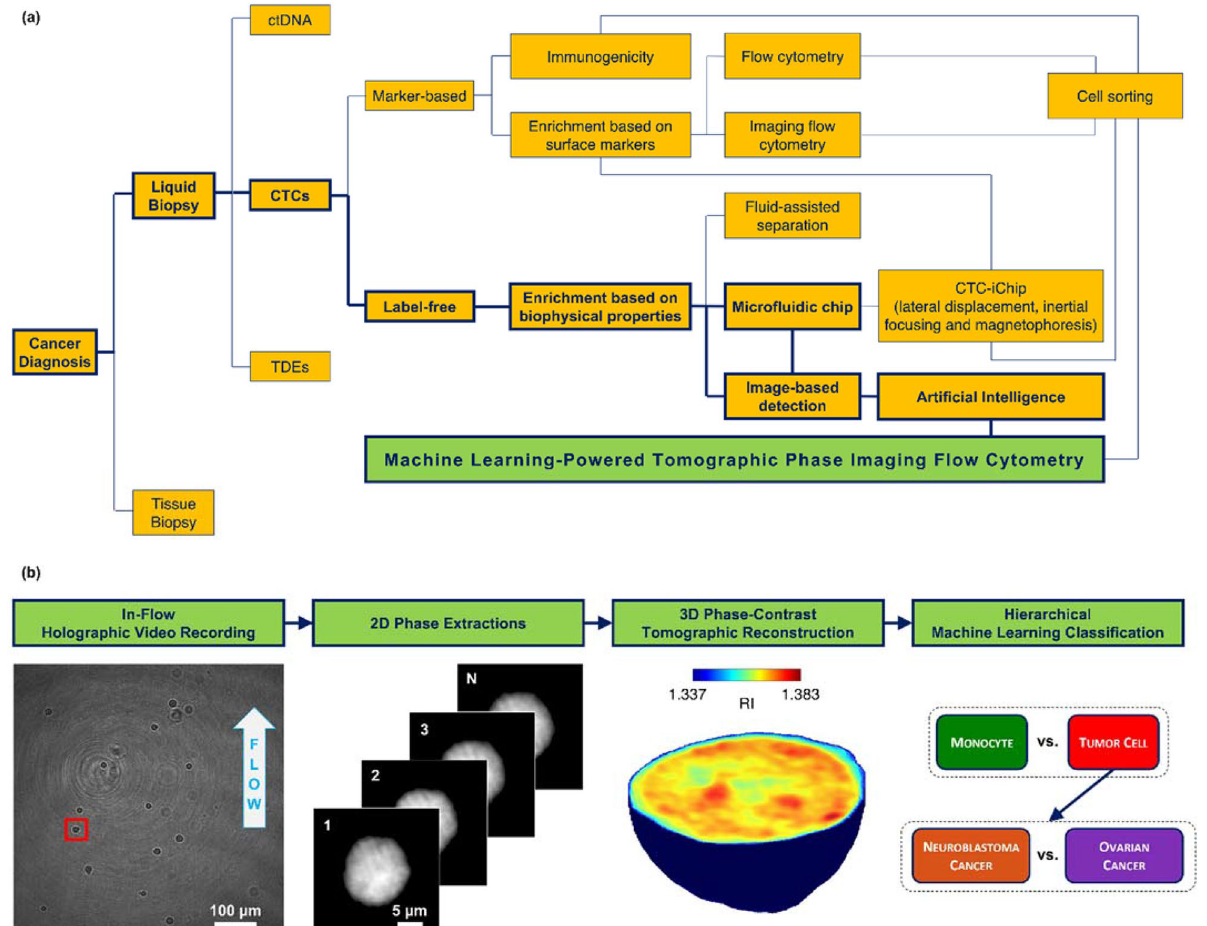
Figure 1. Strategies for implementing liquid biopsy (LB). ( a ) Scheme of the main methods developed for the diagnosis of cancer through LB. The marked pathway leads to the technology presented here for LB applications (green box). ctDNA, circulating tumor DNA; TDEs, tumor-derived exosomes; CTCs, circulating tumor cells. ( b ) Steps of the machine learning-powered tomographic phase imaging flow cytometry. (i) A holographic video sequence containing cells while flowing and rotating along a microfluidic channel is recorded; (ii) for each cell, hundreds of QPMs are numerically computed from the recorded digital holograms; (iii) for each cell, the several QPMs are used to reconstruct its 3D RI tomogram; (iv) the 3D RI tomogram is given in input to a hierarchical ML classifier to detect whether it is a monocyte or a tumor cell and, in the second case, whether it is a neuroblastoma cancer cell or an ovarian cancer